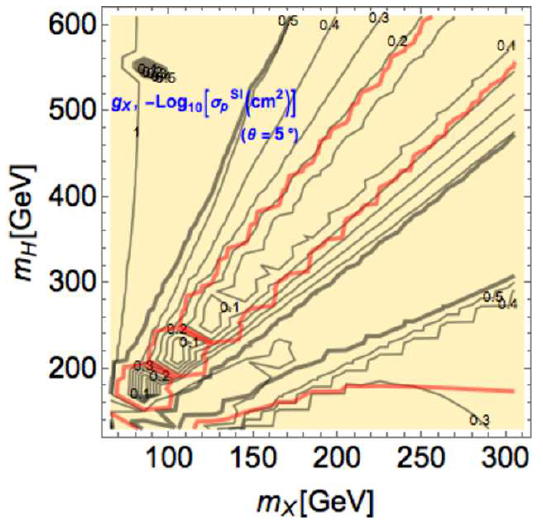
Figure 11 . Contours of g X (black) and σ X = 10 − 46 cm 2 (red) on the ( m X , m H ) for Ω X = Ω obs and θ = 5 ◦